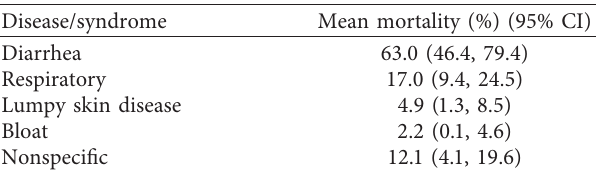
Table 3: Disease syndromes related to calf mortality in dairy production system ( n � 224).